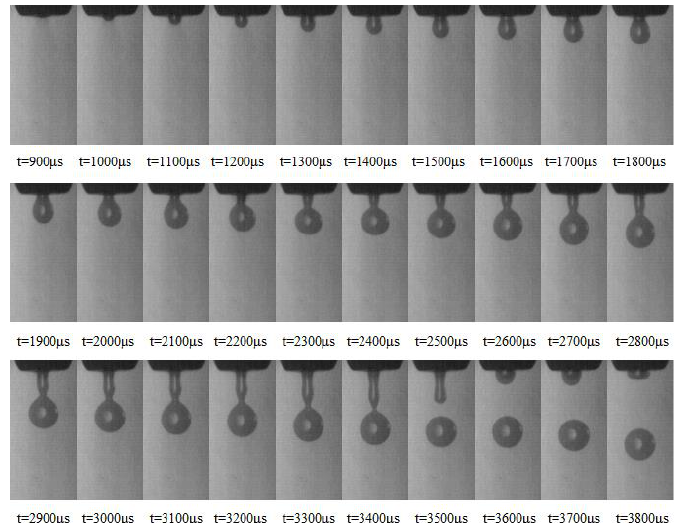
Figure 7. Time-lapse images of microdroplet generation (one primary droplet).